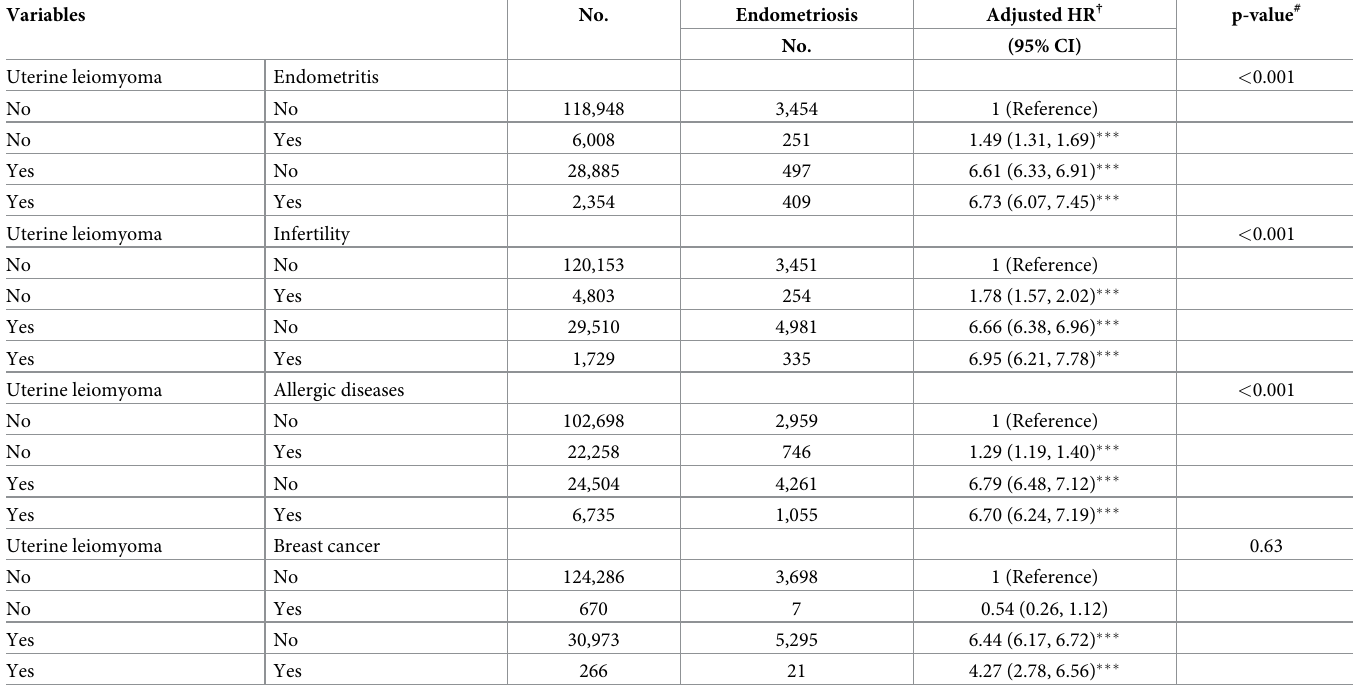
Table 4. Cox’s proportional hazard regression analysis identified a synergistic effect between uterine leiomyoma and comorbidities for the risk of endometriosis.